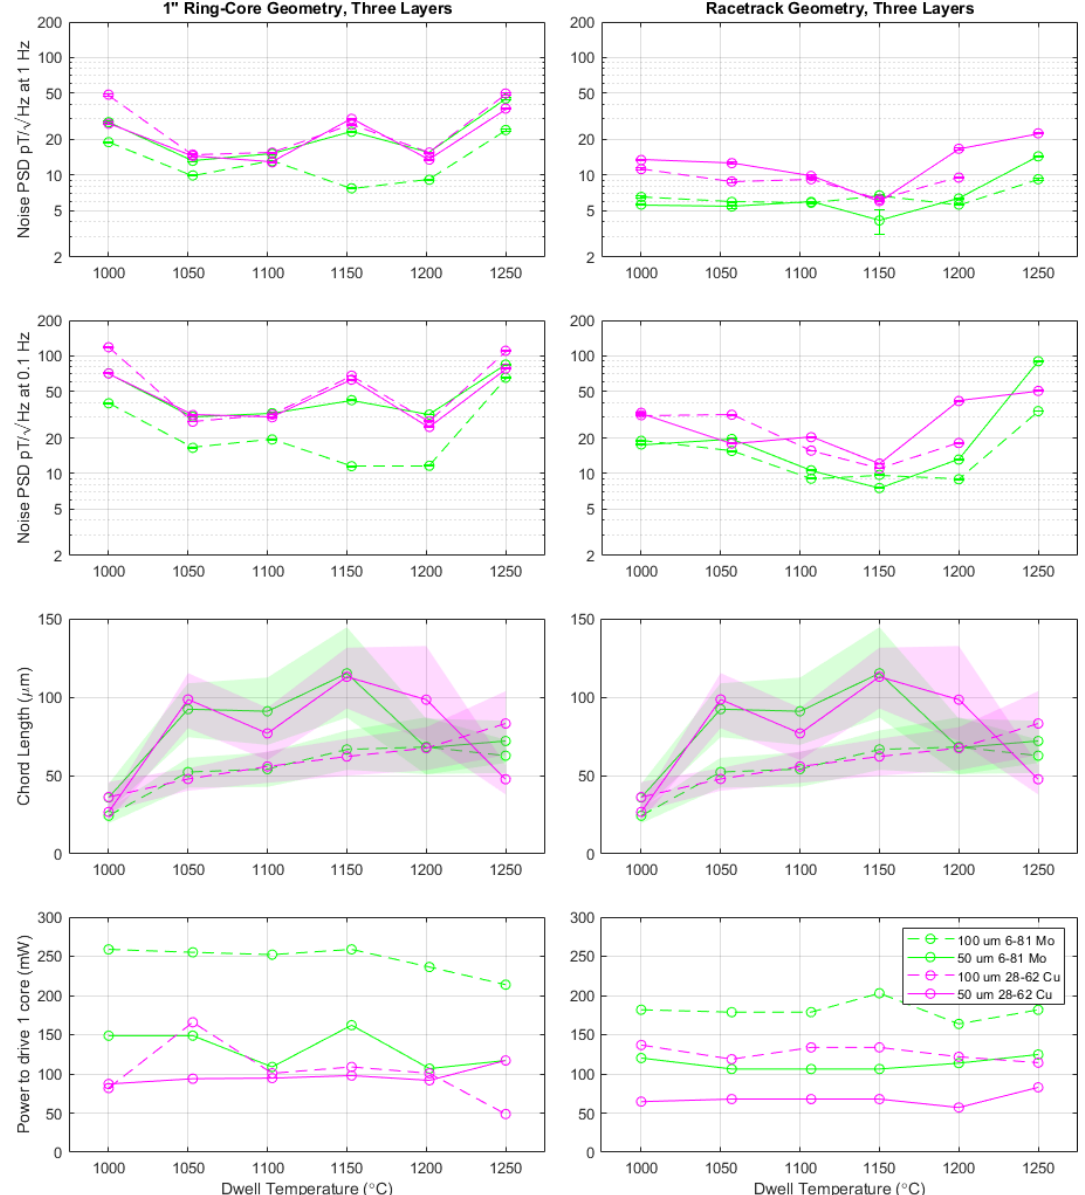
Figure 9. Left column shows 1in. ring cores, while the right column shows racetrack cores. The rows show, top to bottom, noise at 1Hz, noise at 0.1Hz, chord length as a proxy for grain size (same data in both columns), and power required to drive each ring. All results are plotted against the dwell temperature used in their heat